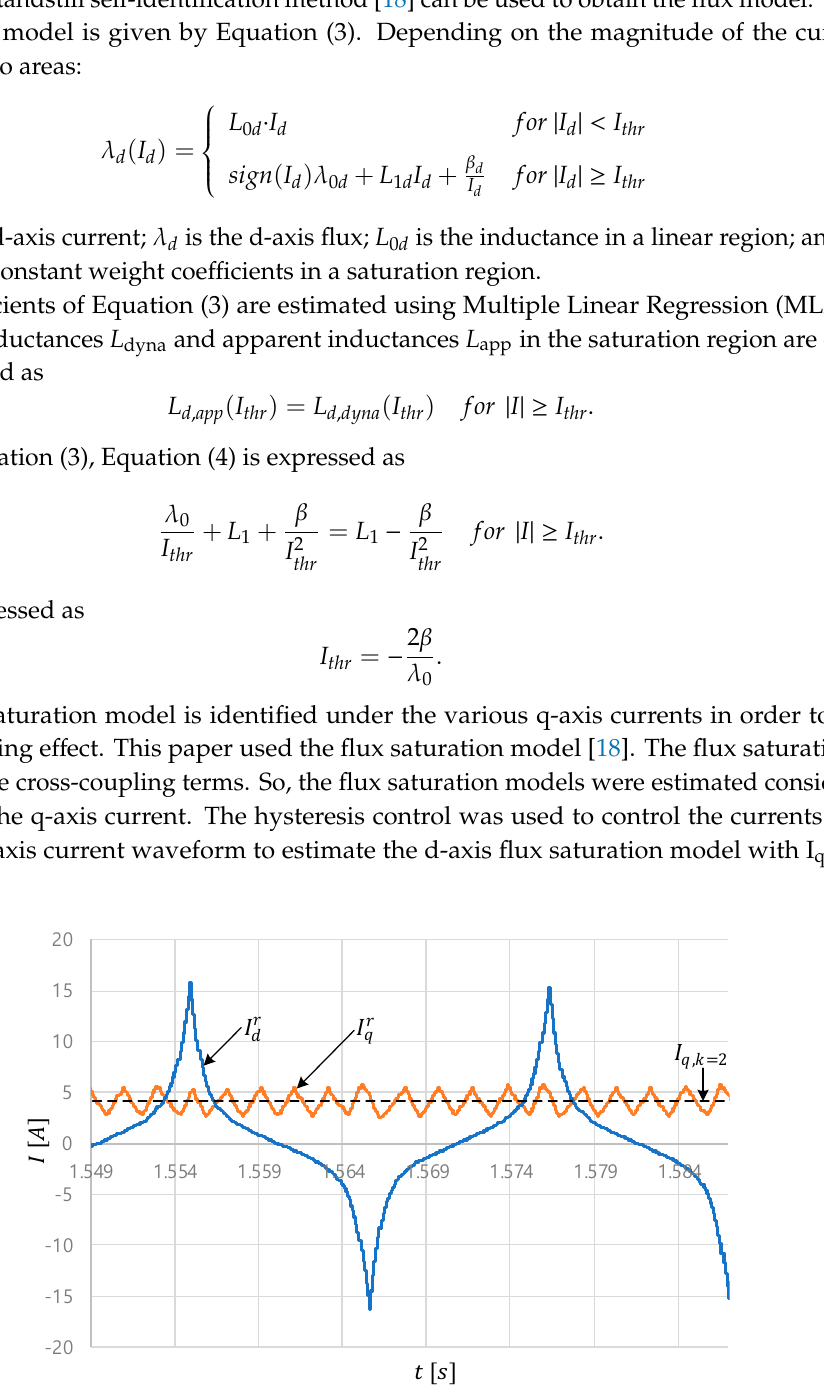
Figure 3. Estimating the d-axis flux model with an I q,k of k = 2 and M =